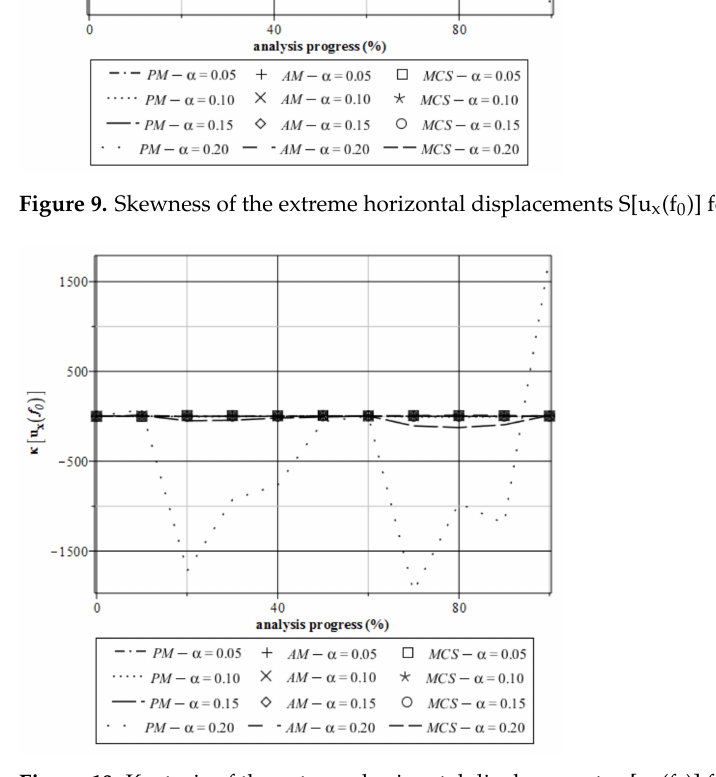
Figure 10. Kurtosis of the extreme horizontal displacements κ [u x (f 0 )] for the